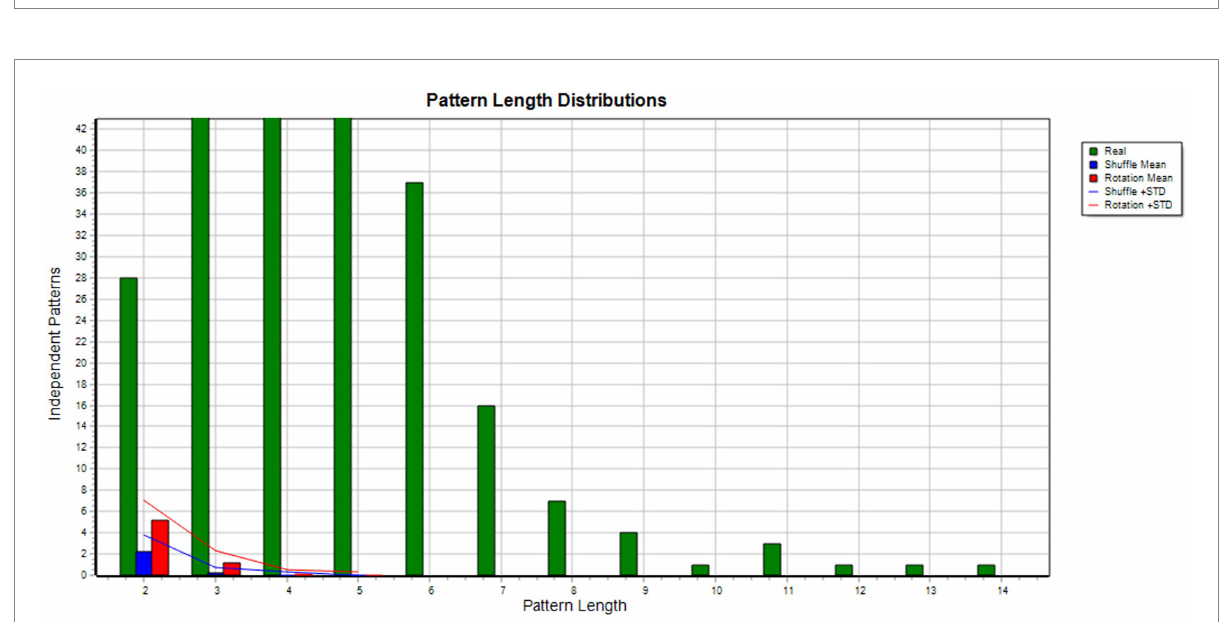
FIGURE 3 Monte Carlo test results. Shows the results of T-shuffling (blue) and T-rotation (red) for TPA of Julia and her foster carer interactions where 282 patterns were found. The difference between real and randomized data is important and no are found in the randomized data with the longer